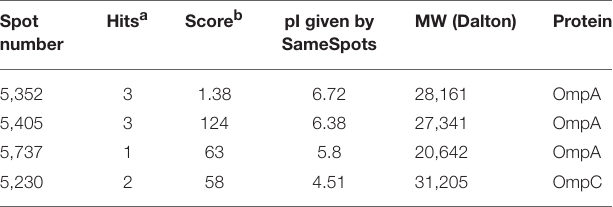
TABLE 2 | Spots analyzed by SameSpots from 2D gels and identified by MALDI-TOF MS during comparison of three strains with no change in attachment to corn stover after shearing treatment (62, 100, and 157) to three strains that showed decreased attachment after shearing treatment (57, 117, and